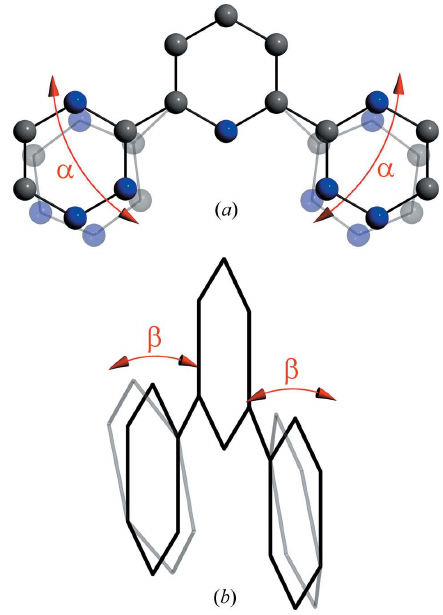
Figure 8 Angles ( a ) and ( b ) describing the in-plane and out-of-plane angles of the triazine rings compared with the pyridine